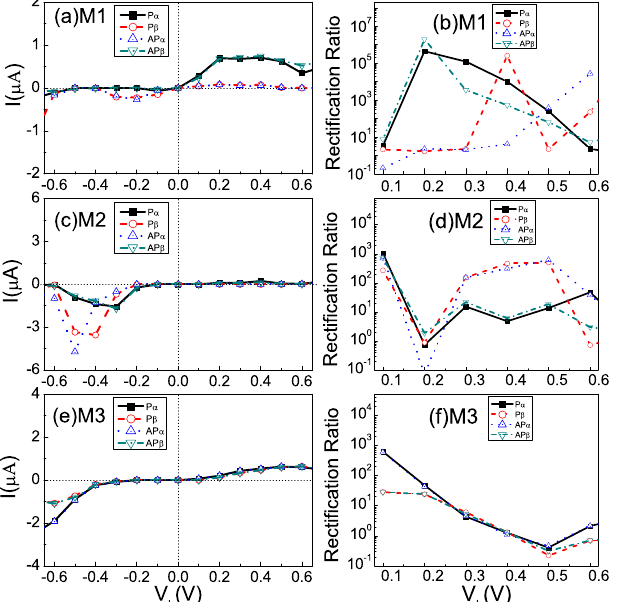
Figure 2. (Color online) Calculated spin-resolved I-V curves and rectifying ratio (RR) with the P and AP configuration, ( a , b ) for M1 structure, ( c , d ) for M2 and ( e , f ) for M3,